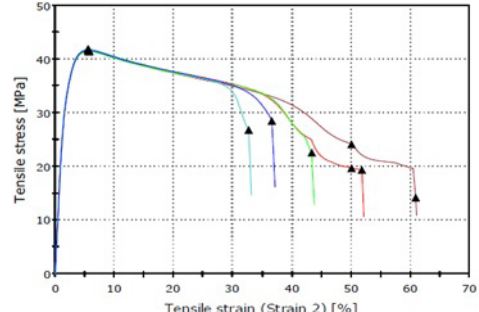
Figure 3. 3-point bending test for virgin PP.